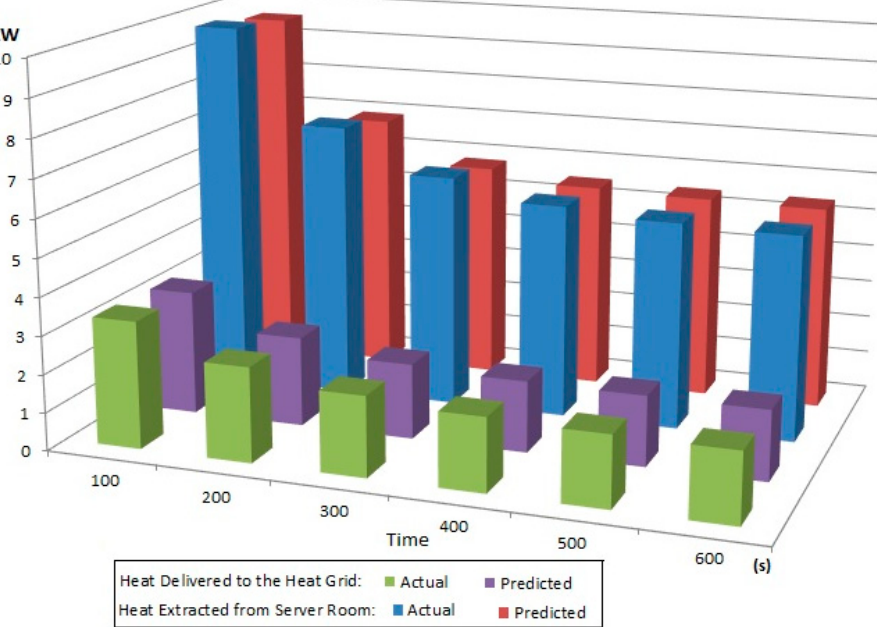
Figure 11. Amount of waste heat delivered to the heat grid and the heat extracted by means of heat pumps heat